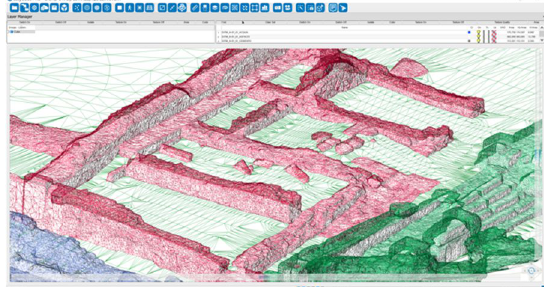
Figure 3. Detail of a section of the Advanced 3D model without textures of the Roman river port of Aquileia